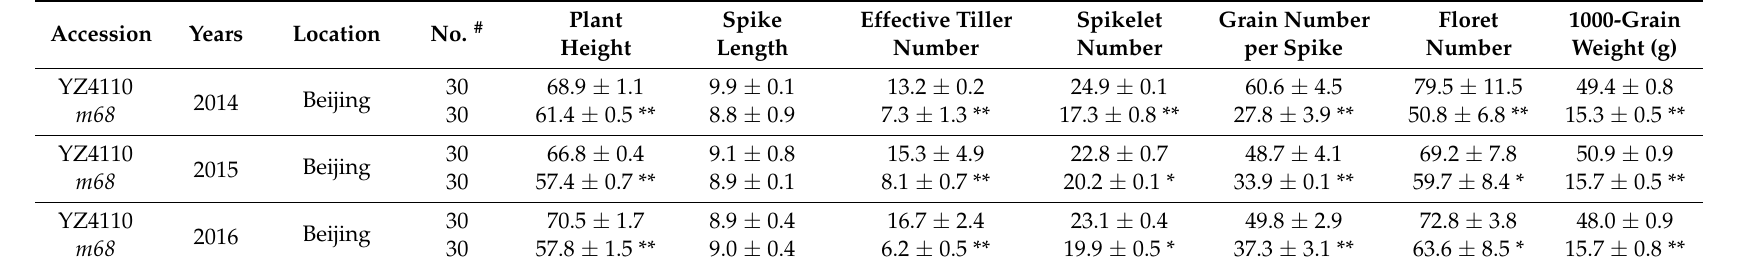
Table 1. Comparison of agronomically important traits between YZ4110 and